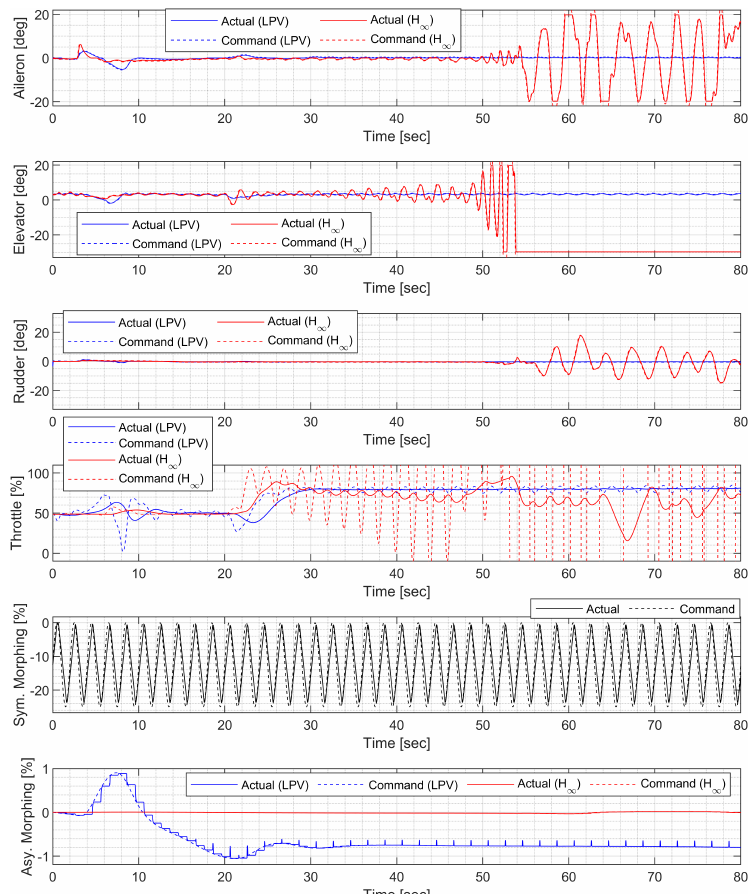
Figure 28. Input history of the helical ascent.